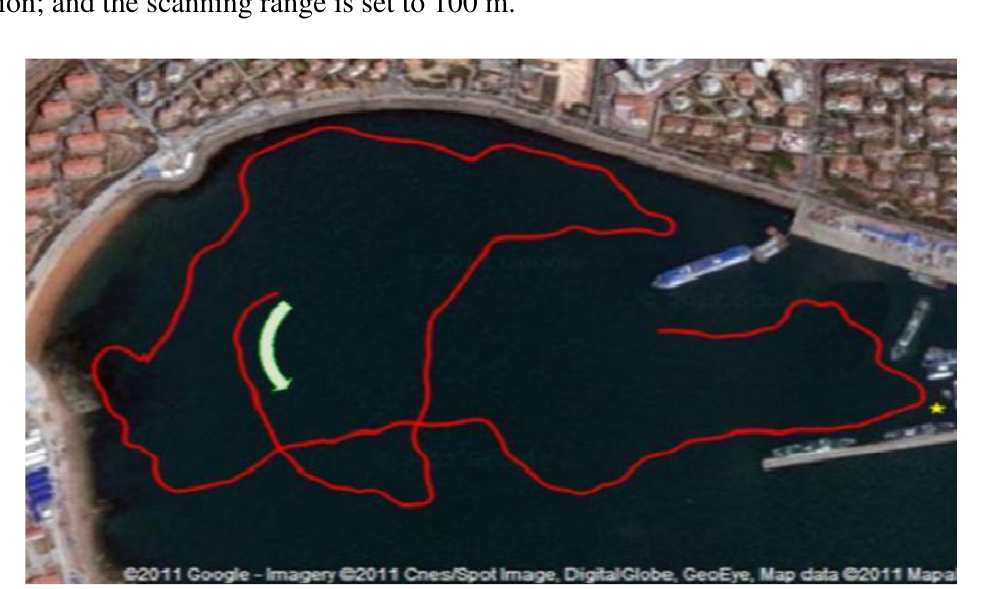
Figure 13. The satellite map of Tuandao Bay and the trajectory of C-Ranger by